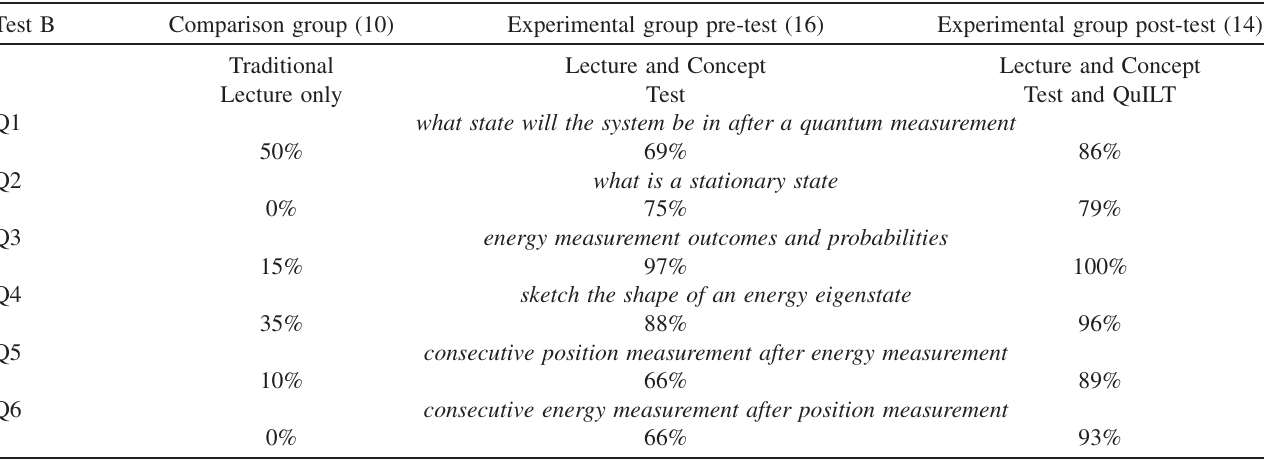
TABLE II. The pre-test and post-test scores on each question of test B. The concepts involved in each question are shown in